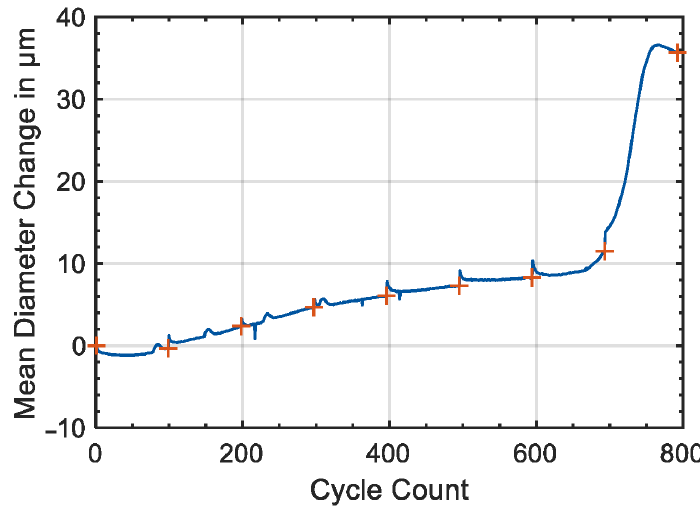
Figure 6. Mean diameter change measured with a strain gauge as a function of cycle count. Orange crosses highlight the time of the check-up. Figure reproduced from [41].